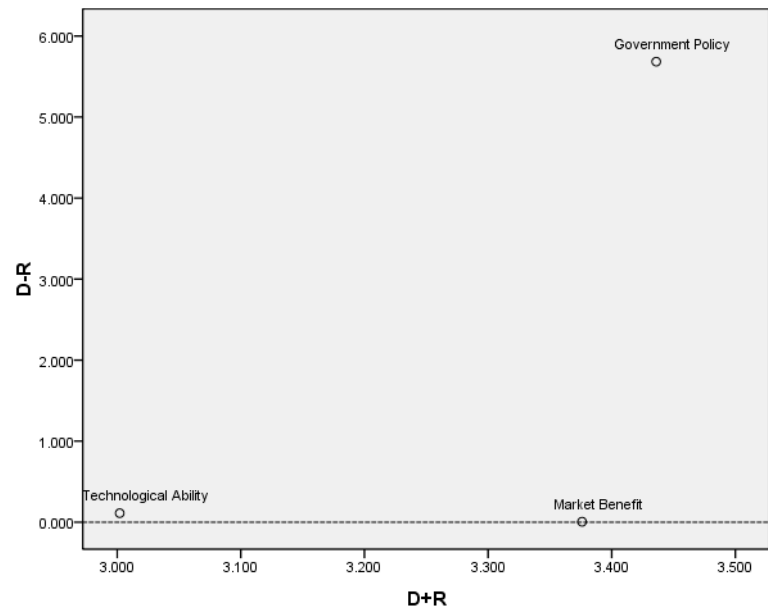
Figure 2. Digraph showing the causal relations between the three main dimensions.